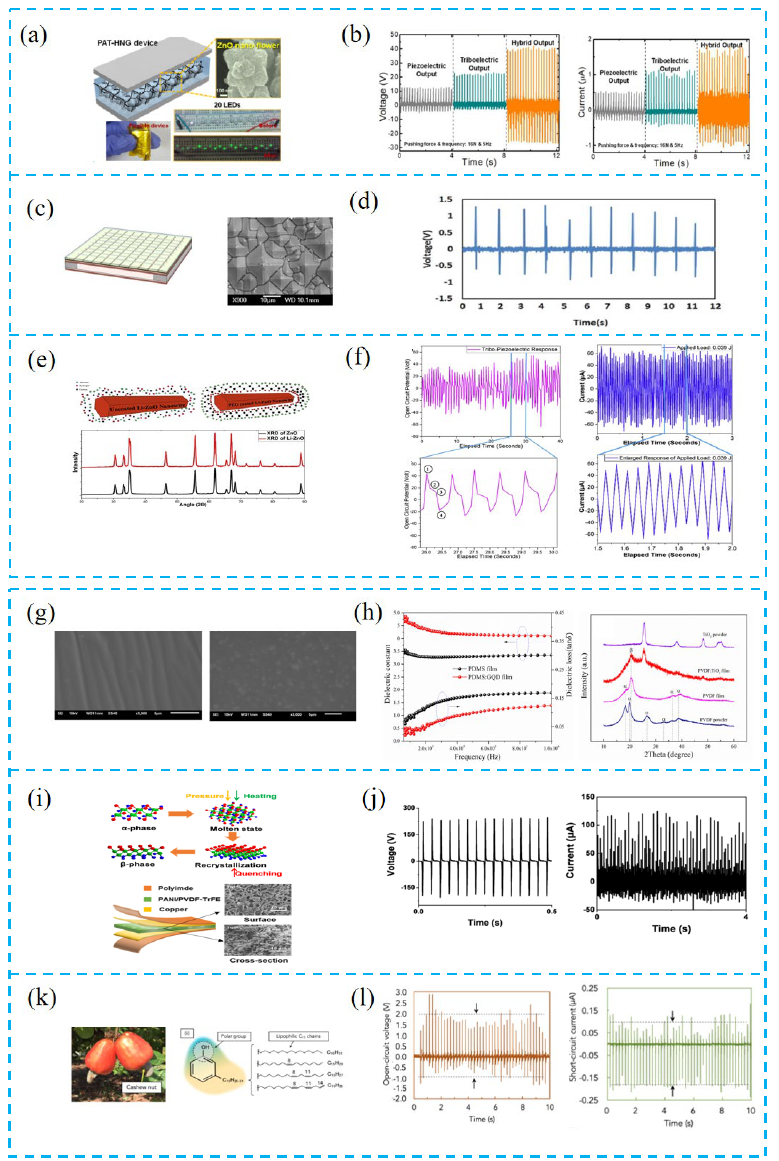
Figure 6. ( a ) Schematic diagram for the PAT-HNG device. ( b ) Output voltage and current of the device under piezoelectric, triboelectric, and hybrid modes. ( c ) Schematic diagram of the device and SEM image of NEFS fiber arrays deposited on the PCB substrate. ( d ) Output voltage of PTCNG. ( e ) XRD diagram of ZnO and Li-ZnO. ( f ) Response of PTCNG and current response of PTCNG under applied load of 0.039 J and enlarged response of applied load of 0.039 J. ( g ) Surface SEM images of PVDF films. ( h ) Dielectric constant and dielectric loss of PDMS and PDMS: GQD films and XRD pattern of PVDF films before and after modification with TiO2 nanoparticle. ( i ) The phase transfor- mation process of PVDF-TrFE under hot pressing and liquid nitrogen quenching, structure diagram of the PTNG, and surface and cross-section SEM images of the aerogel bulk. ( j ) The optimal output voltage and current of the quenched PANI/PVDF-TrFE PTNG. ( k ) Cashew nut as a source for the production of cardanol oil, and chemical structure of cardanol with the indication of the polar group and lipophilic chains. ( l ) Open-circuit voltage and short-circuit current generated by the PTCNG, under f inger tapping (~2 N, ~5 Hz) and with a 10 MΩ probe.